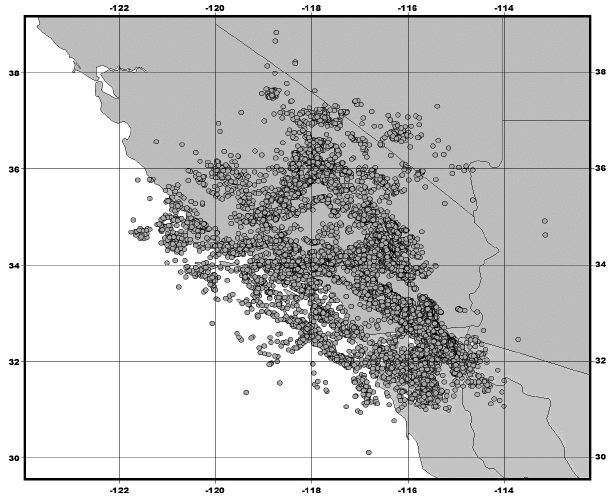
Figure 1. Map of the area covered by the southern California earth- quake catalogue